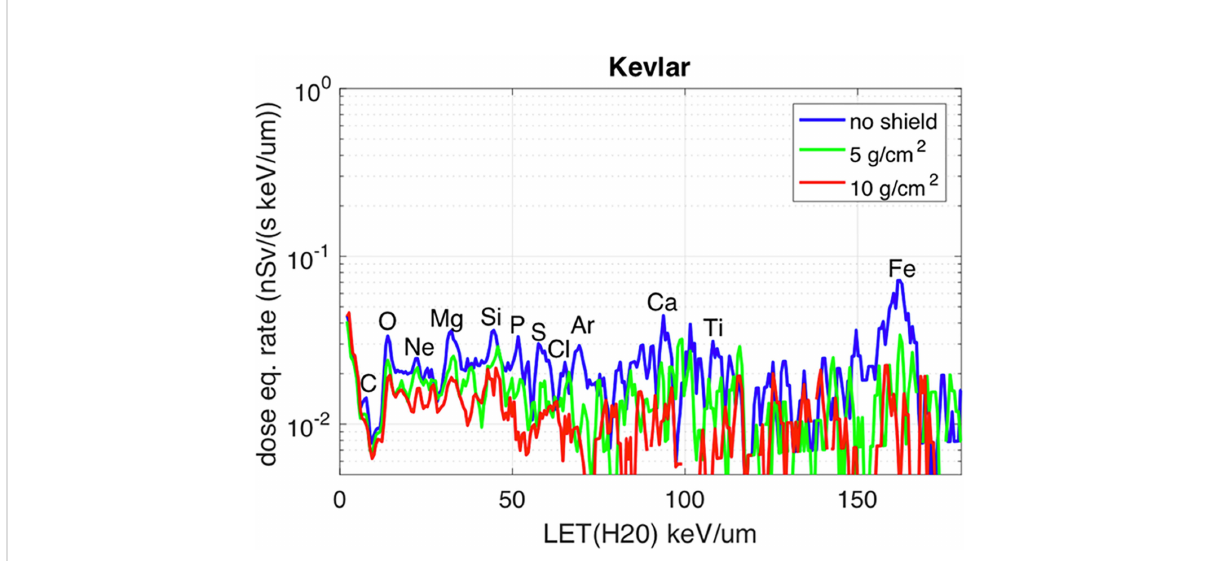
FIGURE 3 Dose Equivalent measured by ALTEA in the Columbus modulus (position 5 in Figure 2), Z direction. Please refer to the blue curve for what is concerned here. The other two curves are related to measurements performed with additional shielding. Most prominent elemental peaks are indicated. [Reproduced from Narici et al., 2017, https://www.nature.com/articles/s41598-017-01707-2].